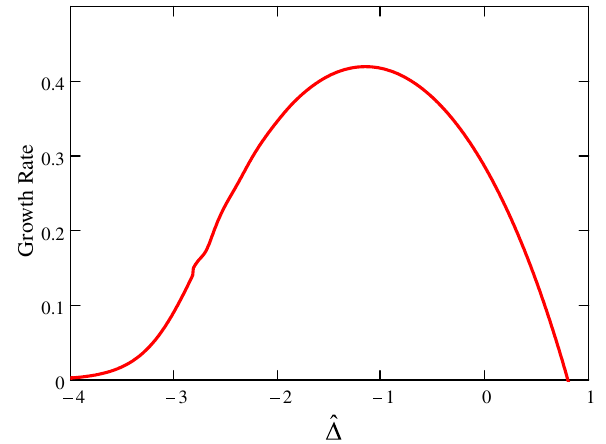
FIG. 5. Numerical solution of FEL growth rate for a Gaussian energy distribution. The growth rate was obtained by